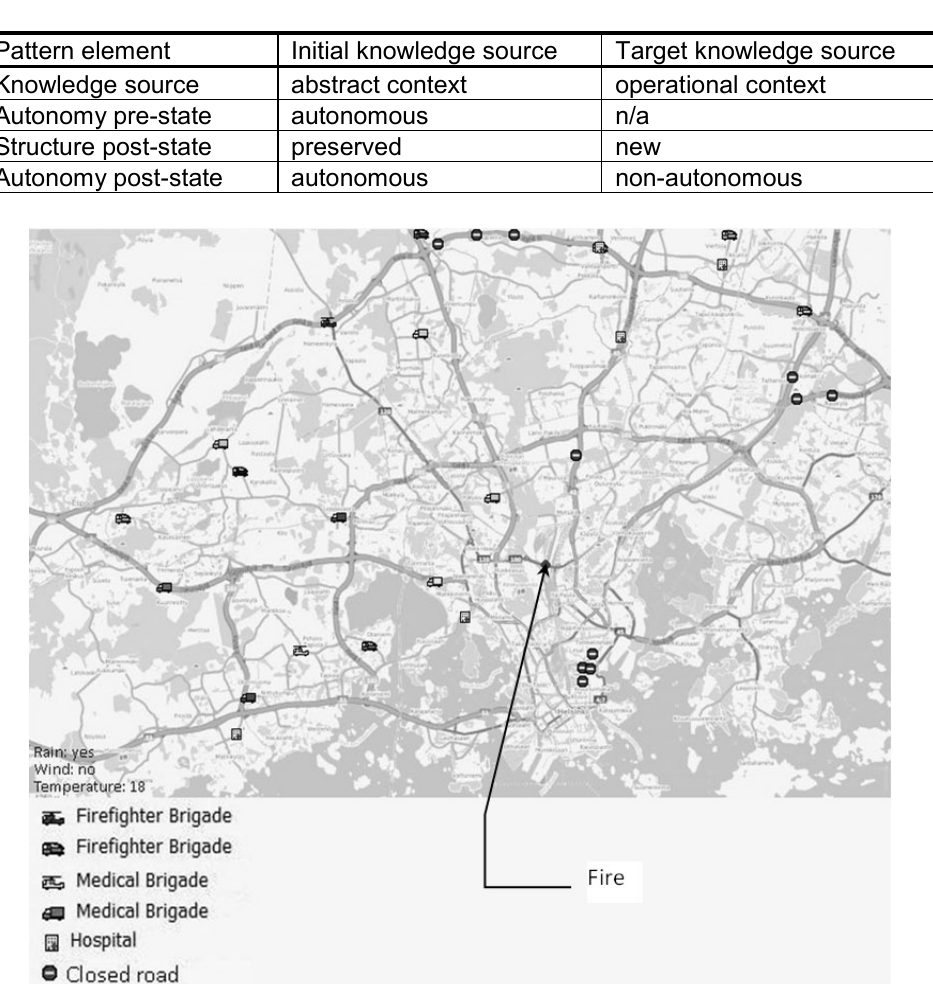
Figure 2. Operational context: new knowledge created from